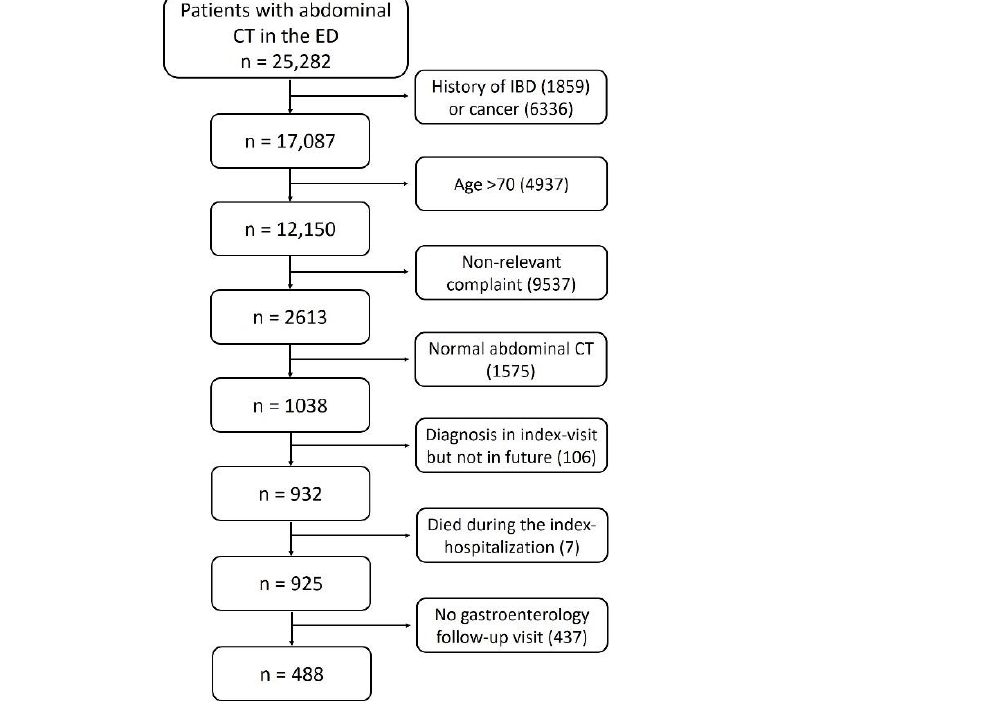
Figure 1. Flow chart showing the screened, included and excluded patients (ED, emergency depart- ment; IBD, inflammatory bowel disease).